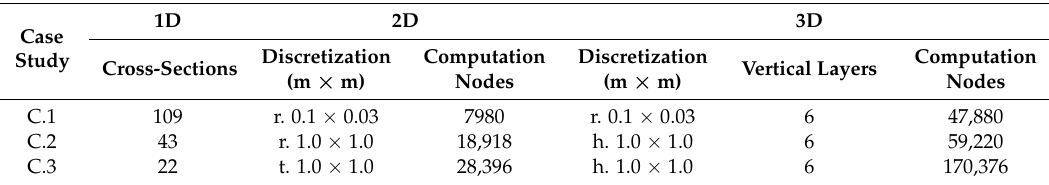
Table 2. Overview of the spatial discretization of all the numerical models (h. = hexagonal, r. = rectangular, and t. = triangular mesh